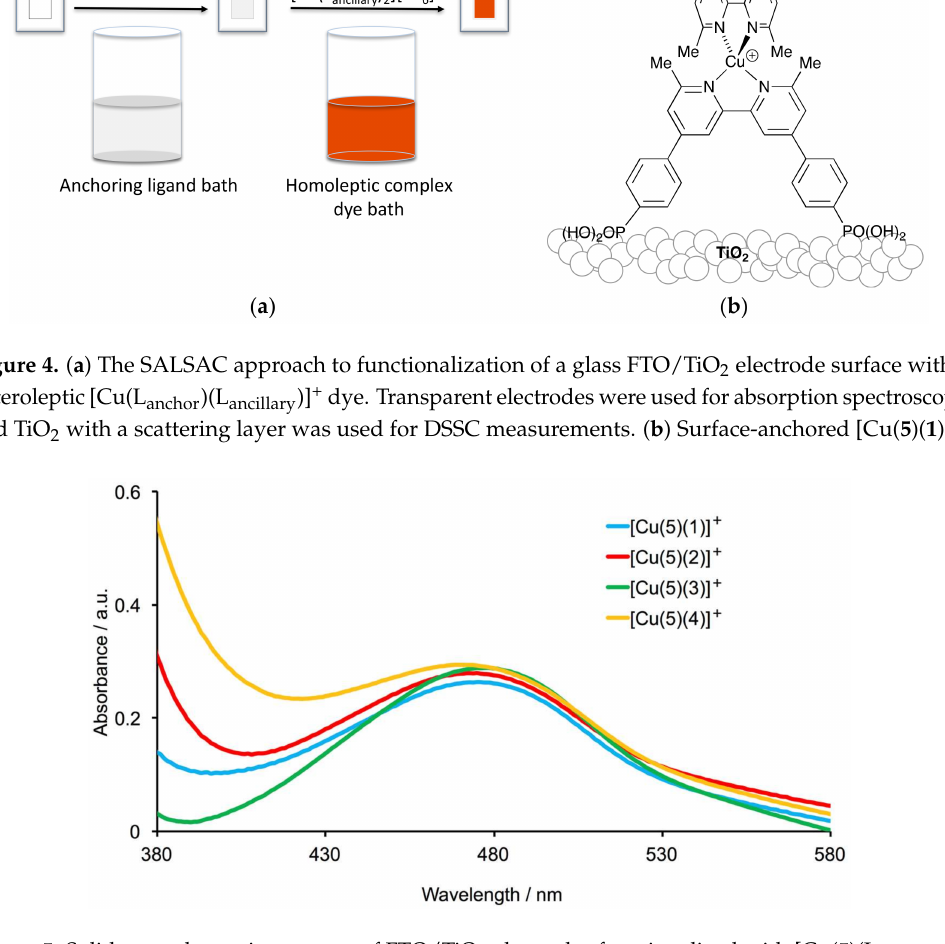
Figure 5. Solid-state absorption spectra of FTO/TiO 2 electrodes functionalized with [Cu( 5 )(L ancillary )] + dyes (L ancillary = 1 , 2 , 3, or 4